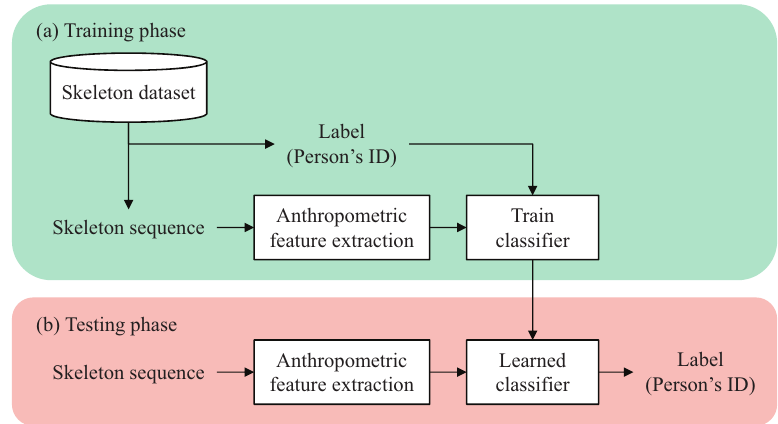
Figure 11. Block diagram of training and testing phases of four benchmark methods.